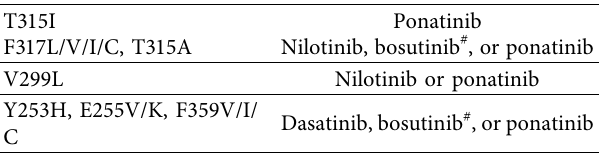
Table 1: European Leukemia Network’ summary of the most appropriate alternative therapeutic options based on BCR-ABL KD mutation status